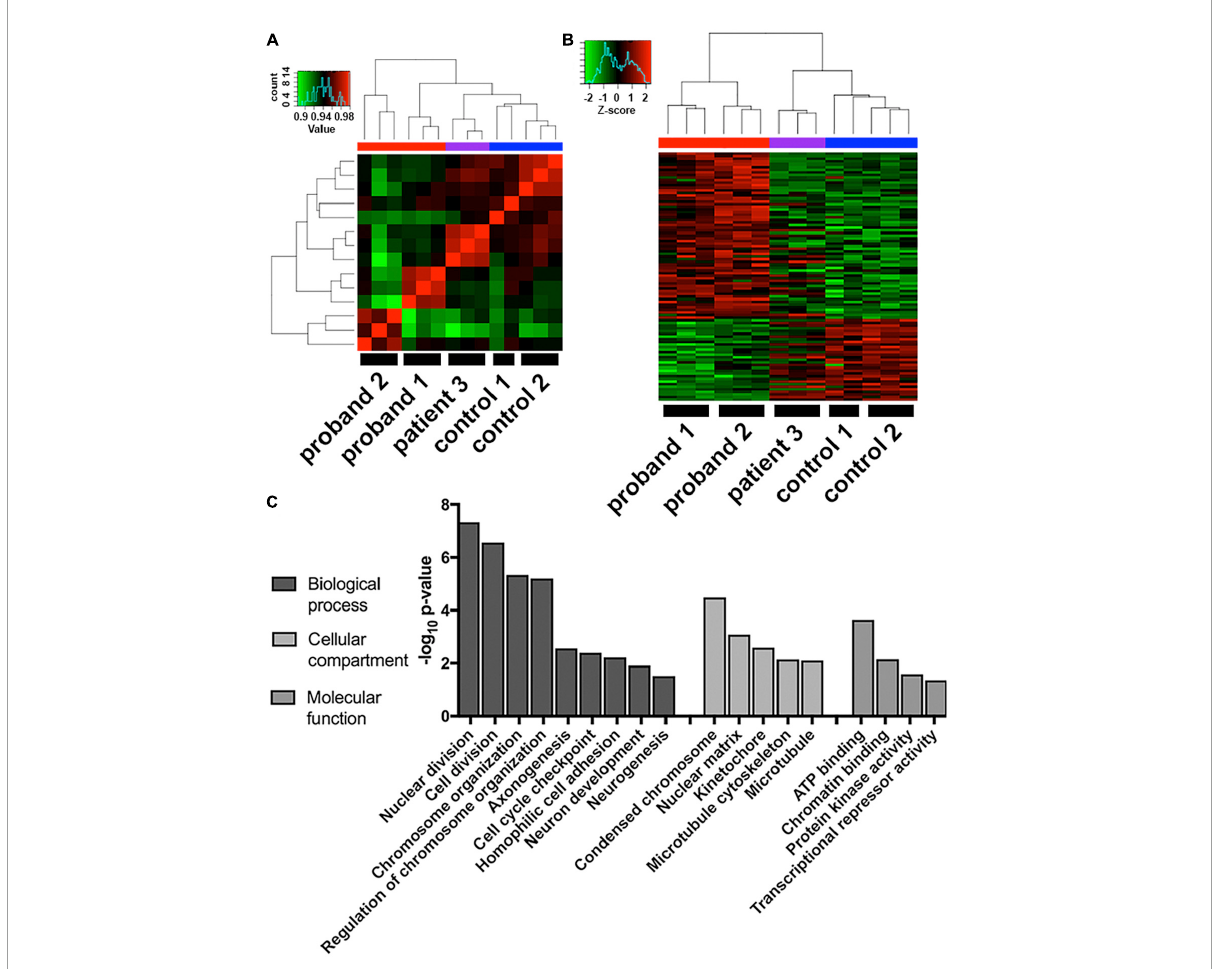
FIGURE3 Transcriptome analysis of 16p13.11 deletion iPSC-derived neurons. (A) Comparison of whole transcriptome sequences from day 14 iPSC-derived neurons across the 5 lines revealed grouping of patient 3 closer to the two control lines than the two proband lines. (B) Comparison of the top 2-fold changed genes from the gene expression data across the 5 lines revealed probands 1-2 and controls 1-2 grouping with each other and patient 3 falling somewhere in the middle. (C) Gene ontology of the whole transcriptome data describing which cellular pathways were most changed in proband 1-2 neurons compared to control 1-2